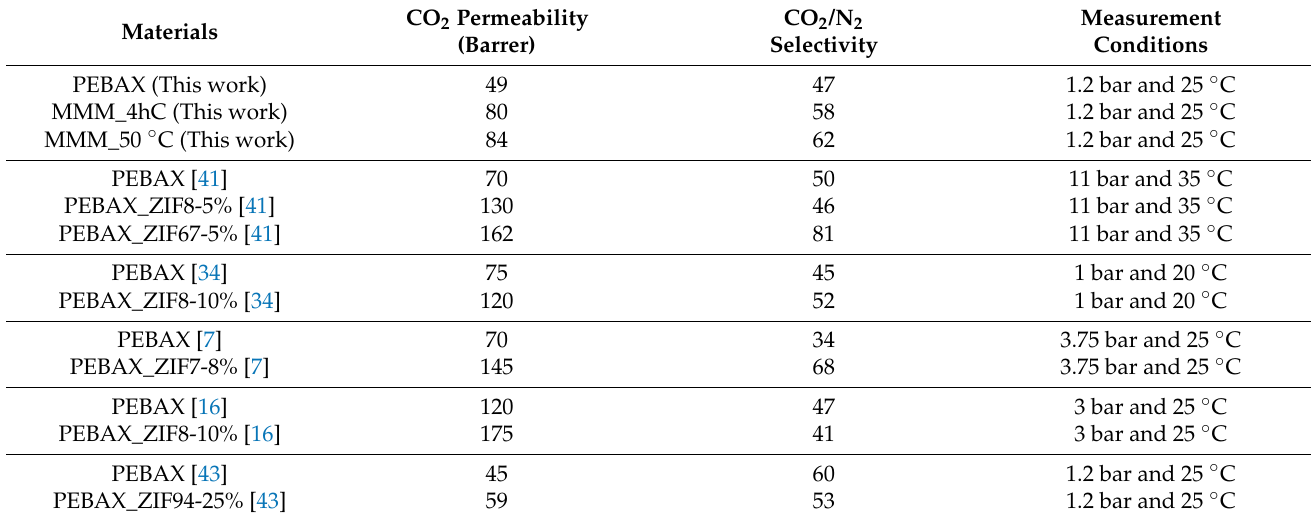
Table 2. Separation performances of others MMMs based on PEBAX MH1657